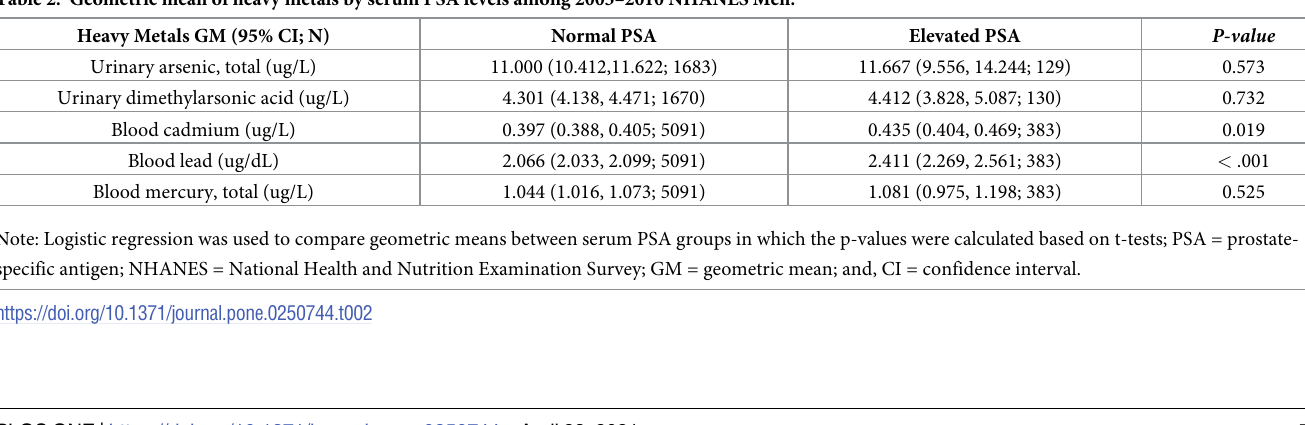
Table 2. Geometric mean of heavy metals by serum PSA levels among 2003–2010 NHANES Men. Heavy Metals GM (95% CI; N)